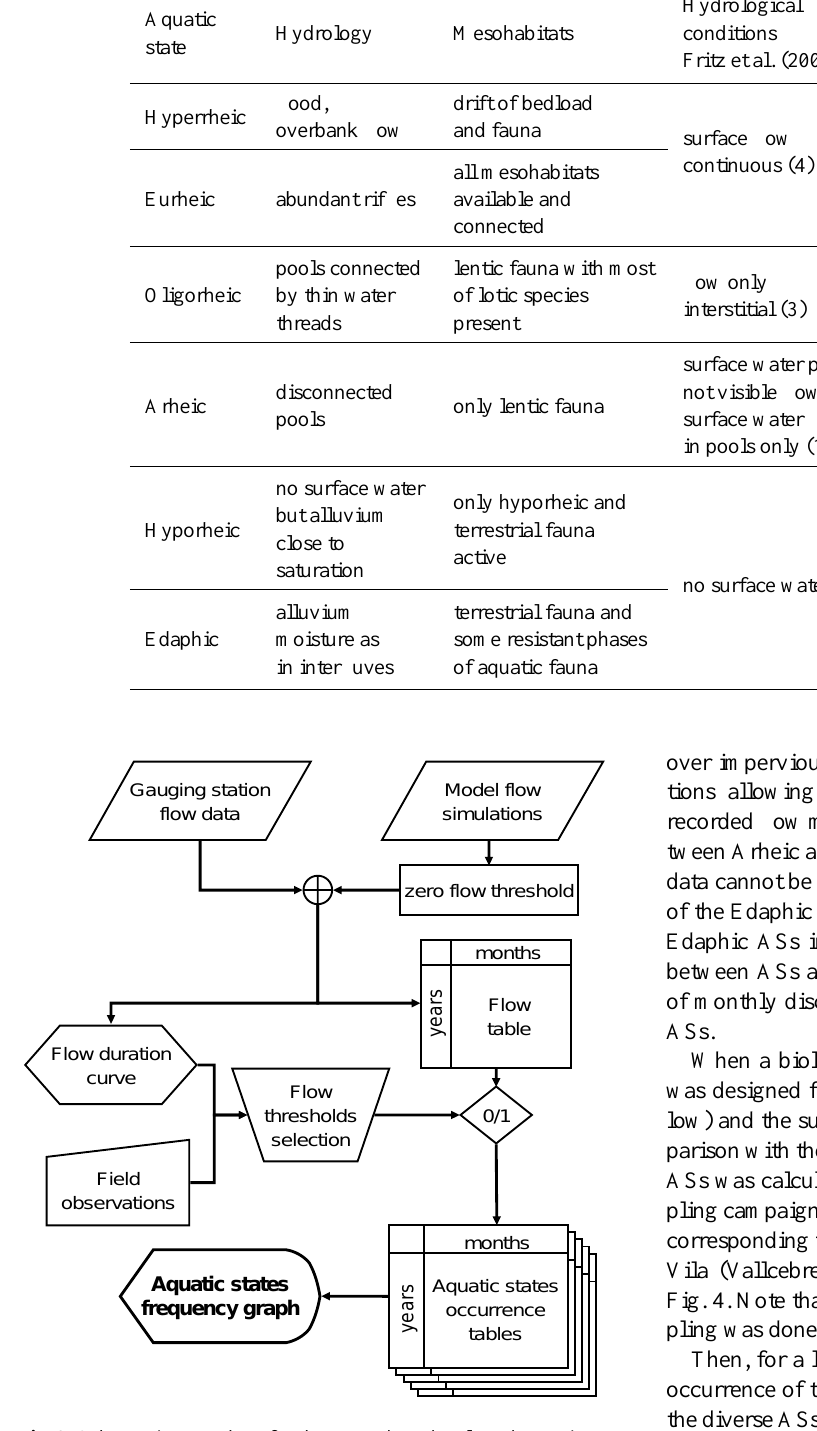
Fig. 2. Schematic flow chart for the procedure developed to estimate the temporal patterns of occurrence of the aquatic states from the available water flow data. The final products are the ASFGs (Fig.